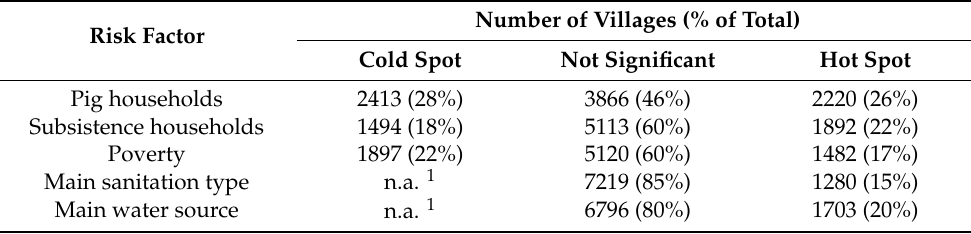
Table 2. Summary of local autocorrelation statistics with 95%